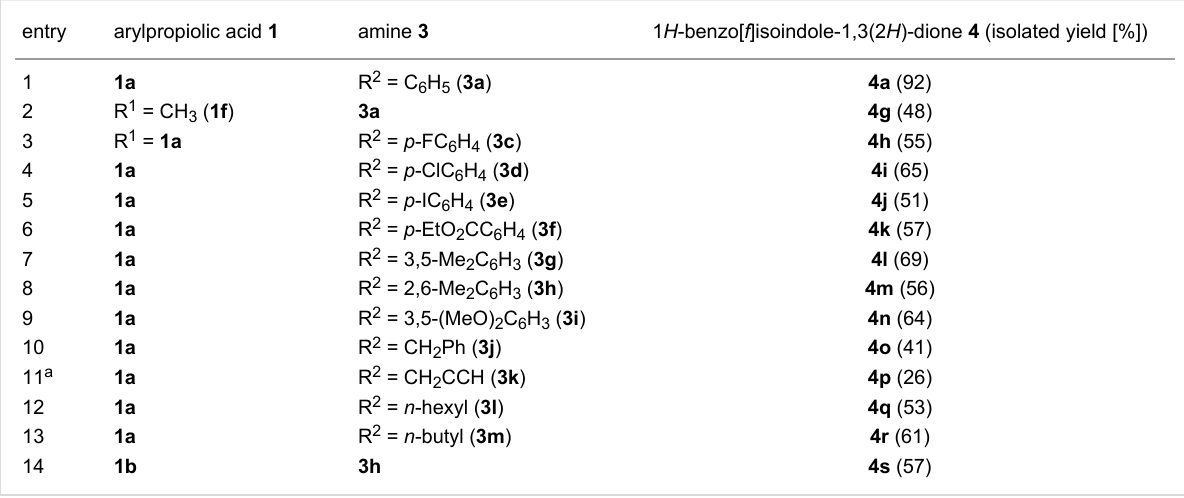
Table 5: Variation of the amine 3 in pseudo three-component syntheses of 1 H -benzo[ f ]isoindole-1,3(2 H )-diones 4 . entry arylpropiolic acid